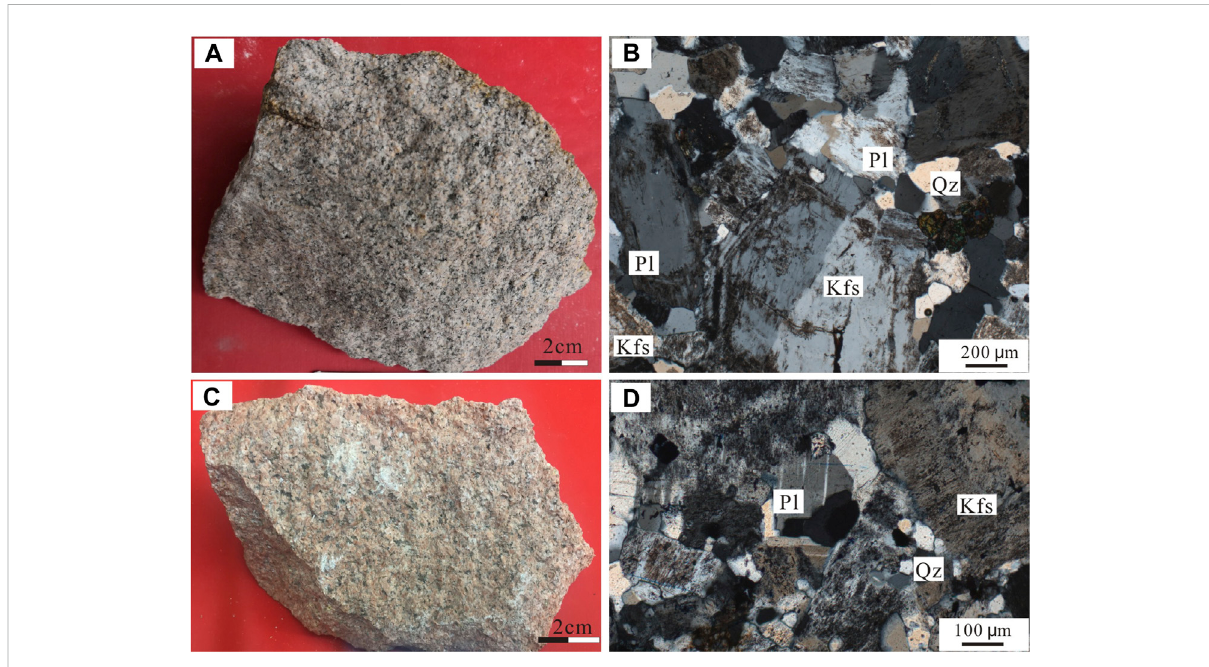
FIGURE 2 Photographs of the quartz syenite (A,B) from the Chishan complex and porphyritic quartz syenite (C,D) from the Longbaoshan complex. Abbreviations: Kfs = K-feldspar, Pl = plagioclase, and Qtz =